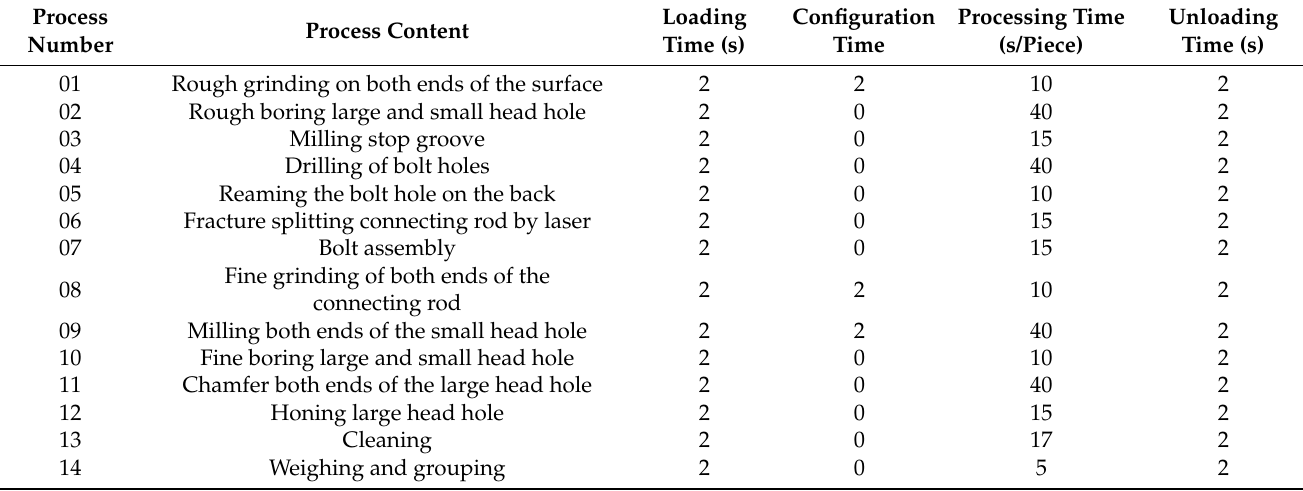
Table 2. The process schedule of the automobile connecting rod production